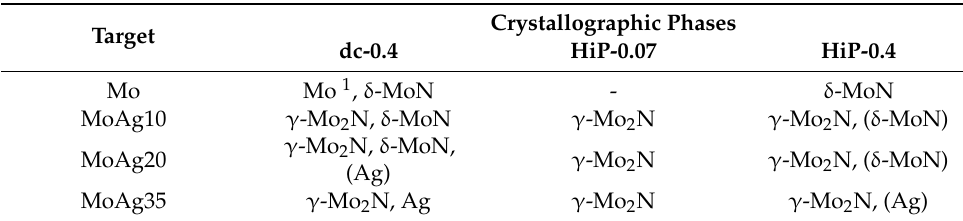
Table 3. Compilation of the crystallographic phases identified for the MoN and MoN-Ag films. In brackets are phases which have not unequivocally been identified.